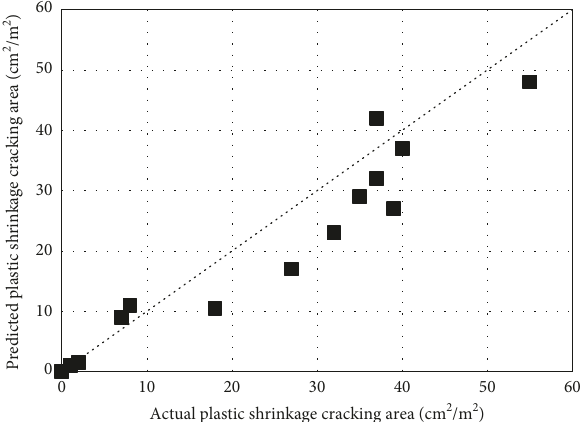
Figure 9: Actual plastic shrinkage cracking area versus the pre- dicted area.